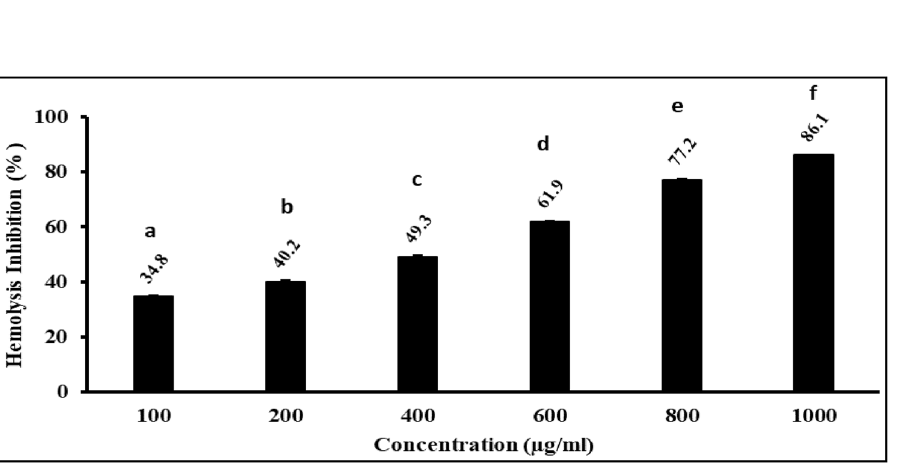
Figure 7. Anti-inflammatory activity of Kocuria sp. RAM1 carotenoids. The letters a, b, c, d, e and f represent significant differences among different homogeneous subsets identified by the post hoc test for p < 0.05. The data represent the mean ± SD (n = 3).